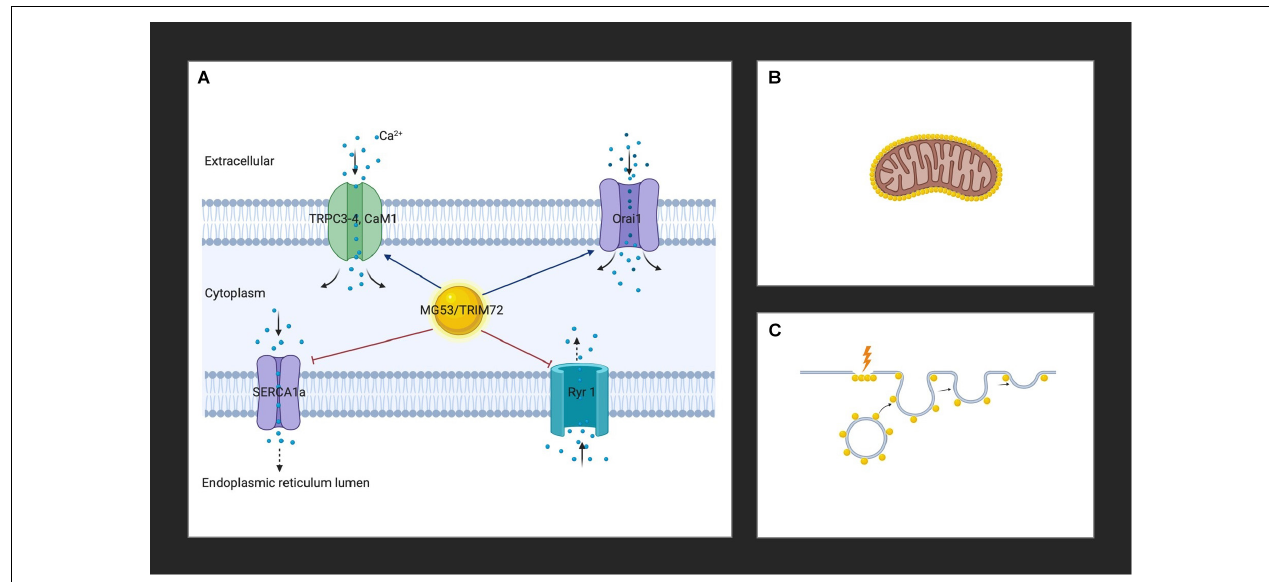
FIGURE 1 | (A) MG53 controls cytosolic calcium through interactions with Orai1, RyR1, TRPC3, TRPC4, CaM1, and SERCA. (B) MG53 aggregates around the mitochondria of skeletal muscle in the presence of reactive oxygen species. (C) MG53 promotes plasma membrane repair by facilitating vesicle translocation following injury. Golden spheres represent MG53. Created with